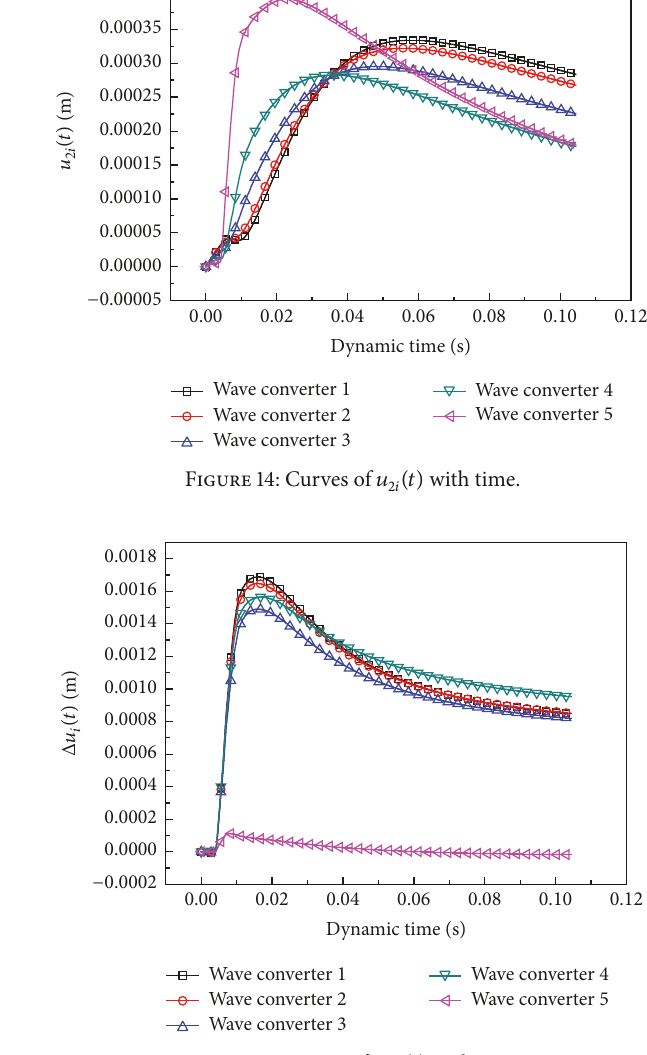
Figure 15: Curves of Δ𝑢 𝑖 (𝑡) with